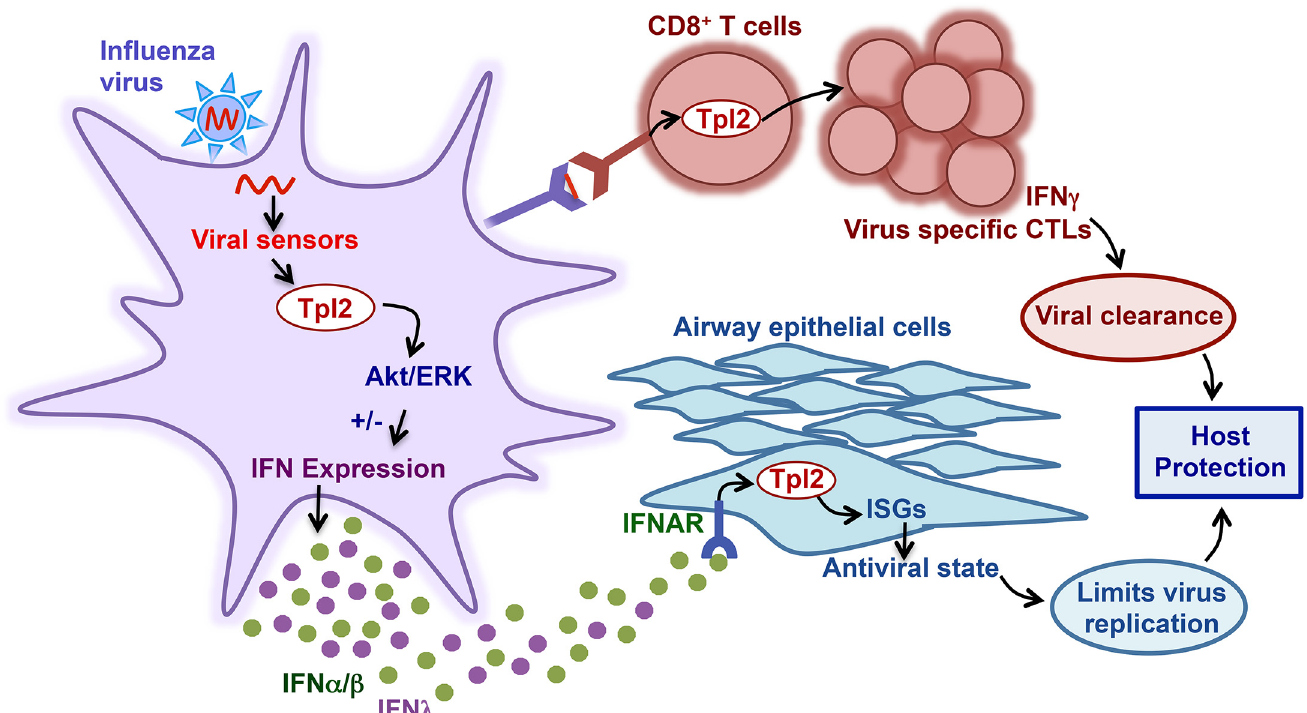
Fig 8. Model of Tpl2 regulation of antiviral immune responses. During influenza virus infection, the viral RNA is recognized by TLR7 (in pDCs) or RIG-I (in other cell types). Virus recognition by these receptors activates various downstream signaling cascades, including Tpl2-ERK signaling, which either positively or negatively regulates secretion of IFN α / β or IFN λ in a cell-type specific manner. Specifically, Tpl2 inhibits TLR- and RLR-induced IFN α / β production in macrophages, but promotes IFN α / β and IFN λ in TLR-stimulated pDCs. Tpl2 is also involved in transducing Type I IFN signals. Moreover, Tpl2 regulates induction of ISGs, which are important in limiting virus replication. In addition to early innate responses, Tpl2 promotes expansion of virus-specific CD8 + T cells that facilitate viral clearance from infected lungs. Therefore, by integrating both innate and adaptive antiviral responses, Tpl2 promotes host protection during influenza virus